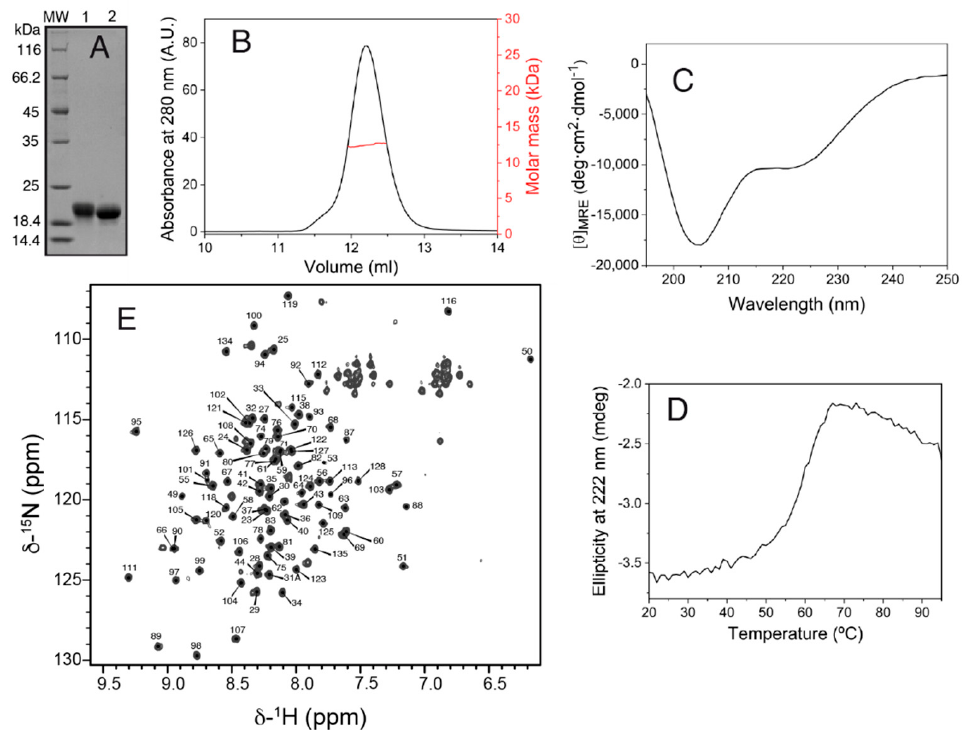
Figure 1. Structural characterization of Salp15. ( A ) Reducing SDS-PAGE of purified Salp15 in the unfolded form (lane 1, preparative gel filtration elution peak at 73.7 mL) and in the folded form (lane 2, elution peak at 80.1 mL). ( B ) SEC-MALS analysis of the folded Salp15. ( C ) Far-UV circular dichroism spectrum of the folded Salp15. ( D ) Thermal denaturation of the folded Salp15 followed by the change in the ellipticity at 222 nm. ( E ) 1 H- 15 N HSQC NMR spectrum of Salp15 with the residue-specific assignment of the backbone amide resonances.